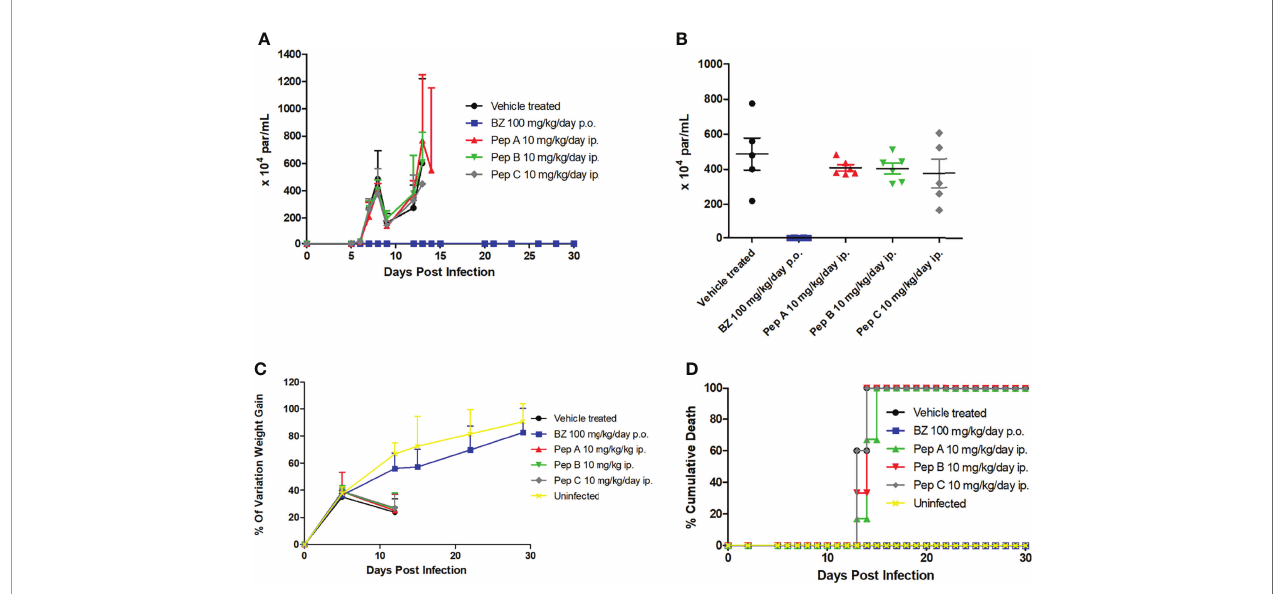
FIGURE 3 | Effect of peptides and benznidazole upon a mouse model of acute Trypanosoma cruzi infection. (A) Parasitemia curve, (B) data dispersion of blood parasitism at 8 days postinfection, (C) ponderal curve, and (D) cumulative